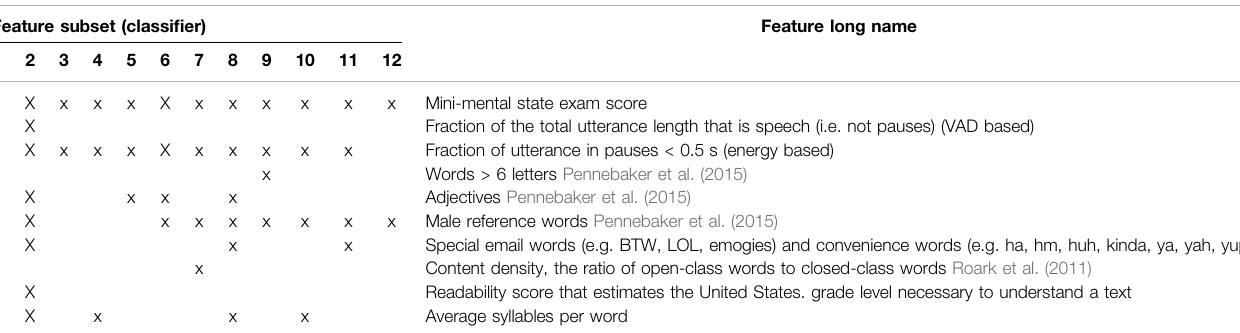
TABLE 4 | Selected Features By Classi fi er. Feature subset (classi fi